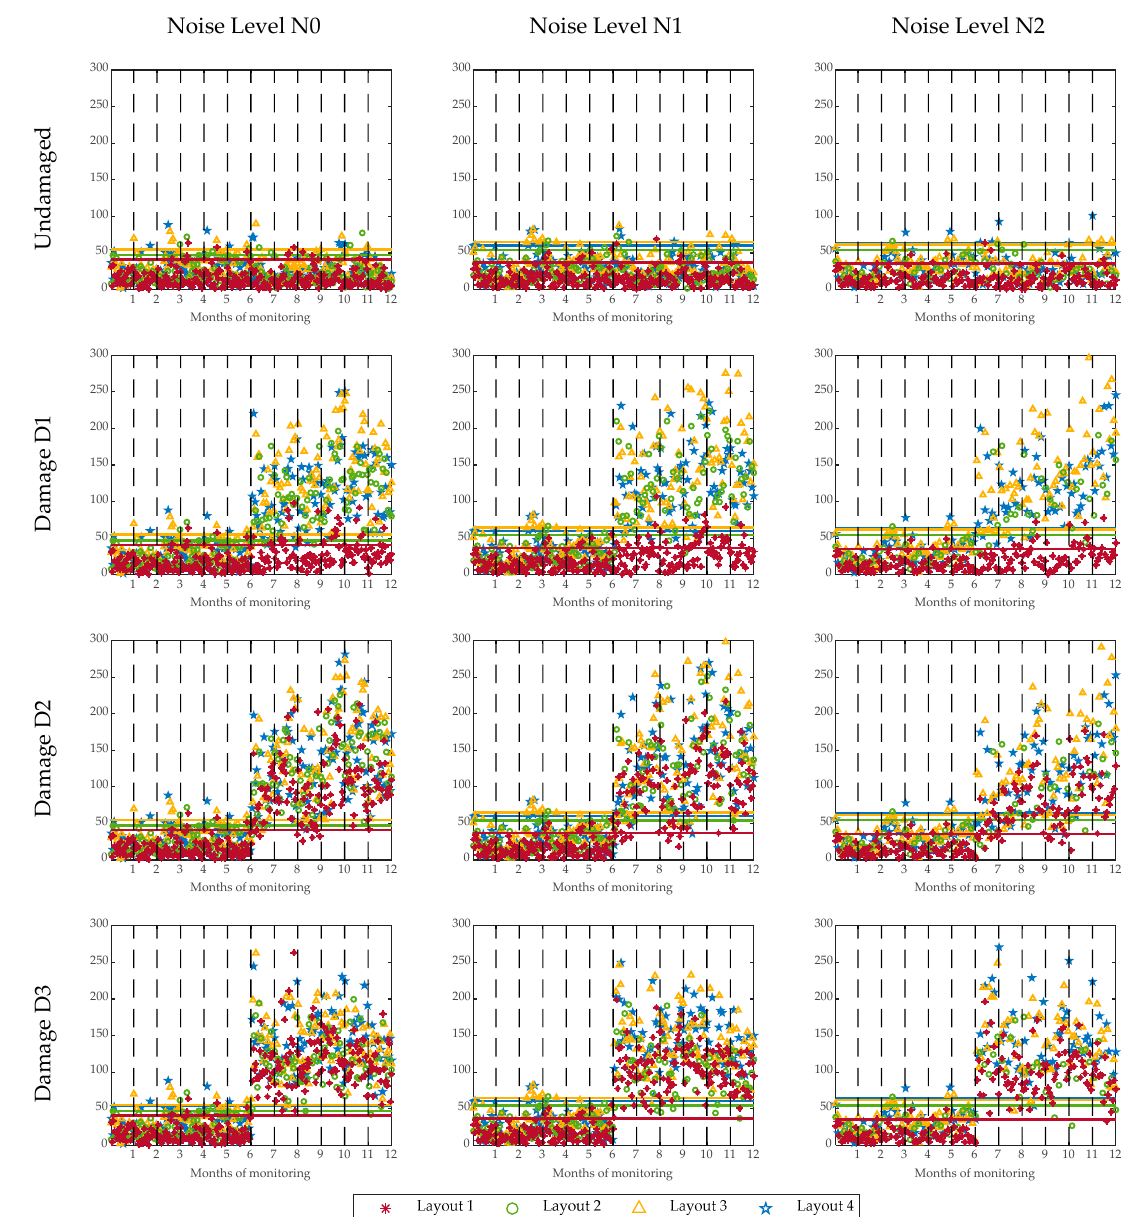
Figure 9. T 2 control charts corresponding to Layouts 1–4 and for noise levels, N0, N1 and N2, considering a scenario undamaged and three damage scenarios, D1, D2 and D3 (the horizontal lines represent the upper control limit (UCL) of each solution).